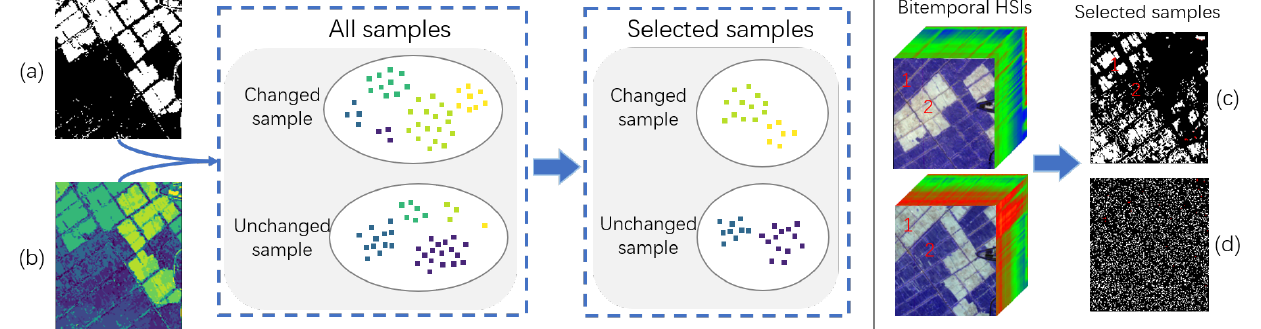
Figure 3. Sample selection based on group confidence. ( a ) Pseudo-labels. ( b ) Multiclass map. ( c ) Sample loss-based method. ( d ) Group confidence-based method. In ( c , d ), white is the selected samples with correct label, red is the selected noisy samples, and black is the discarded